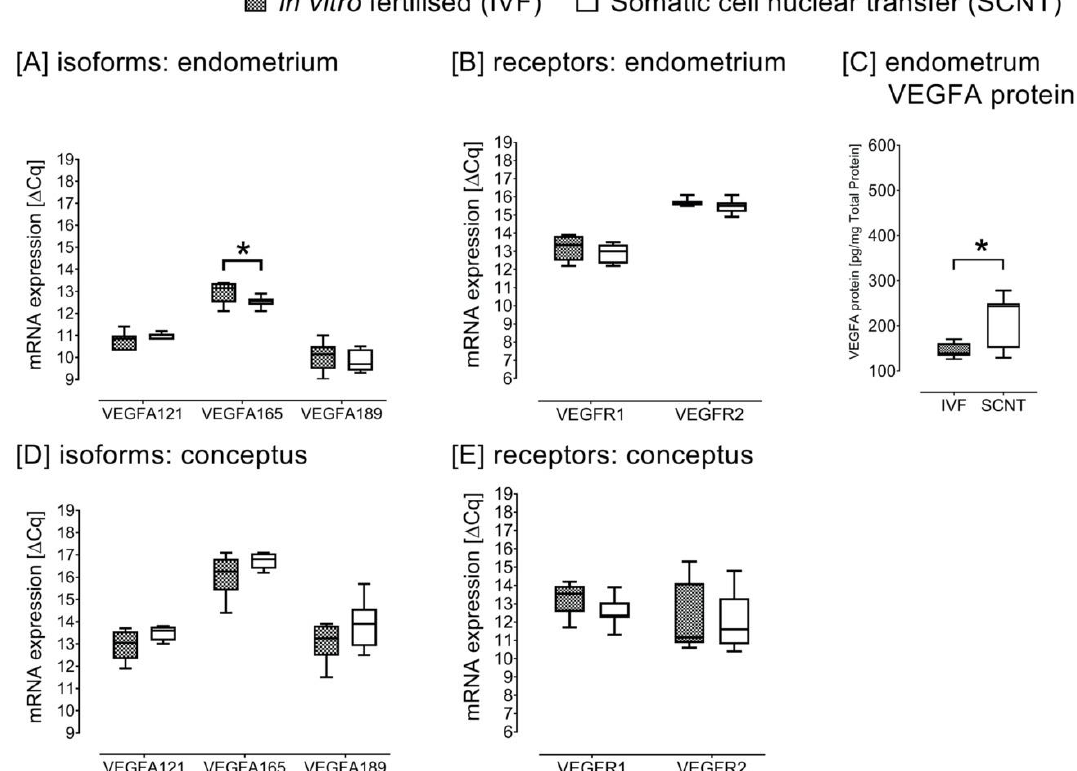
Figure 4. Day 18 post insemination vascular endothelial growth factor A (VEGFA) isoforms ( A ) and VEGF receptors ( B ) mRNA expression in the intercaruncular endometrium of heifers gestating the in vitro fertilised (IVF) and somatic cell nuclear transfer (SCNT) conceptuses. Endometrial VEGFA protein abundance ( C ) and conceptus mRNA expression ( D , E ) are presented ( n = 8 for the respective IVF and SCNT treatments). Asterisk (*) indicates significant differences at p < 0.05.